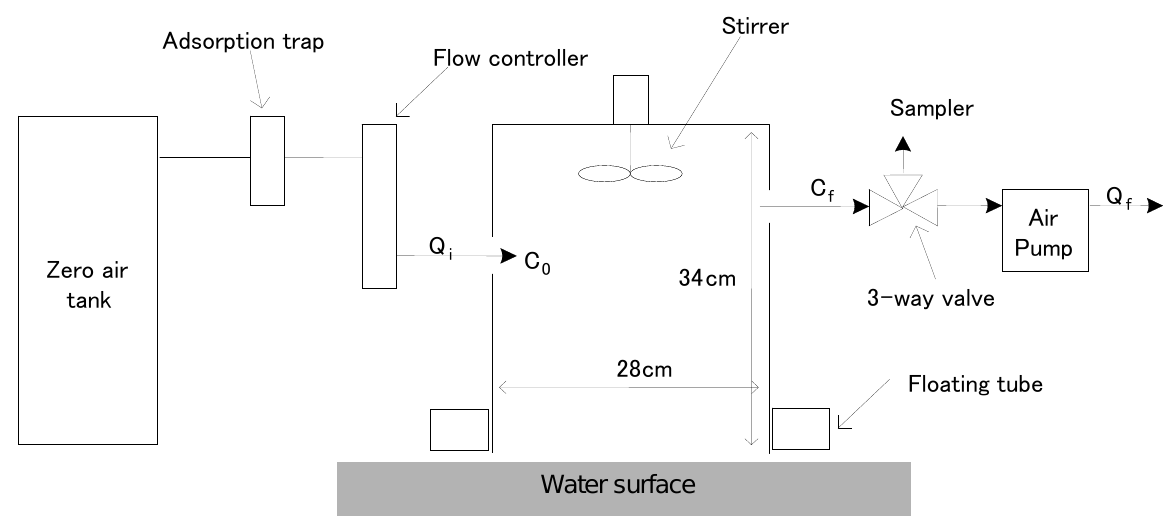
Figure 2. A Schematic Diagram of Dynamic Flux Chamber